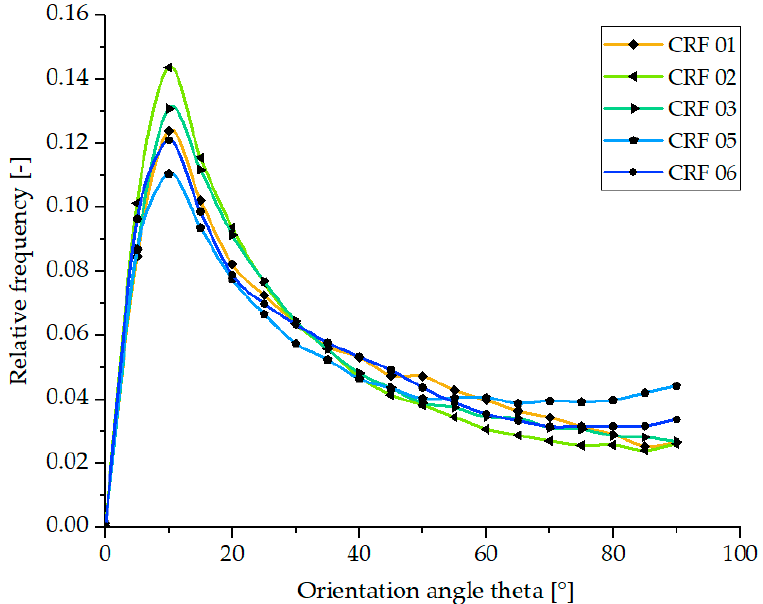
Figure 10. Quantitative plot of fiber orientations of RCF reinforced specimens produced with open hot runner system obtained by fiber tracing evaluation of the µCT data.